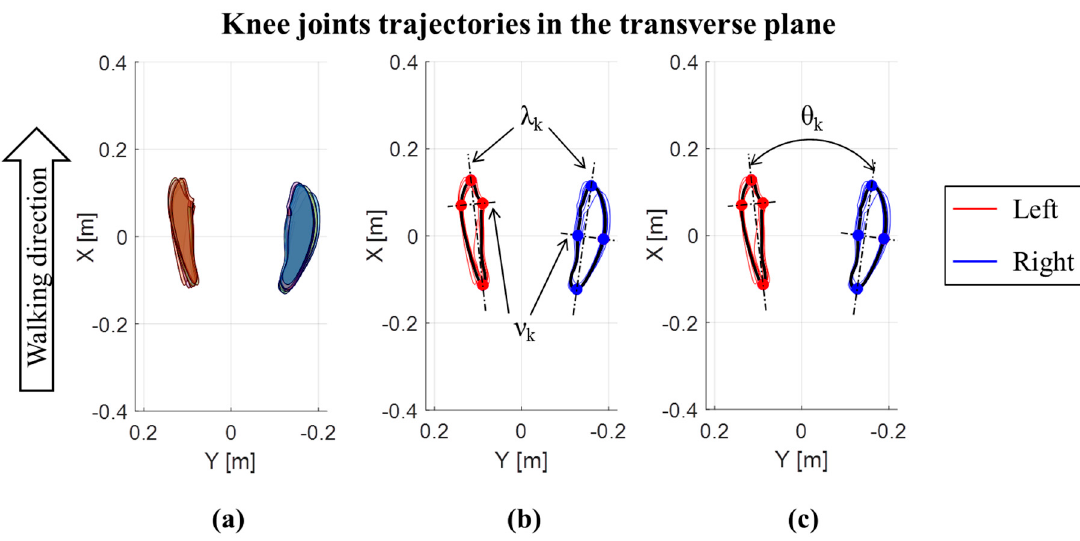
Figure 2. Knee joints trajectories in the transverse plane for an OW subject: ( a ) Area of each left and right step; ( b ) major ( λ k ) and minor ( ν k ) diameters of the average knee trajectories; ( c ) knee opening angle ( θ k ) between the left and right major axes of average knee joint trajectories.